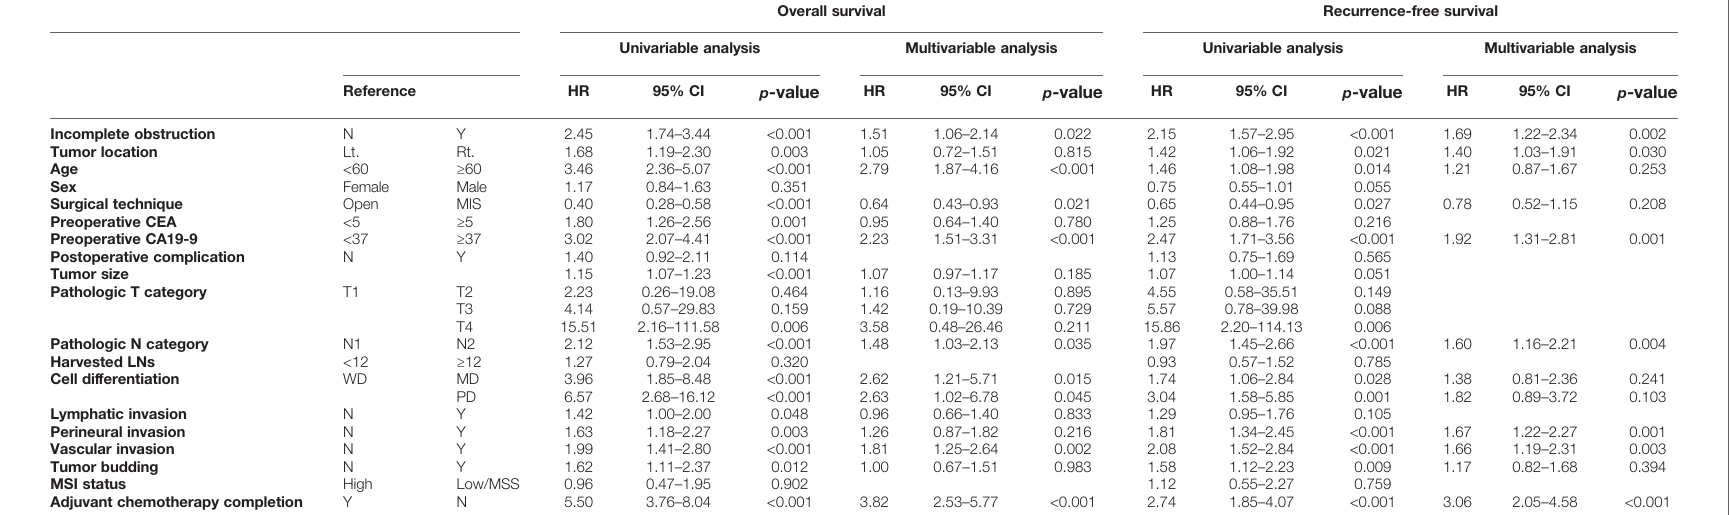
TABLE 6 | Univariable and multivariable Cox regression analysis of overall survival and recurrence-free survival of stage III colon cancer.